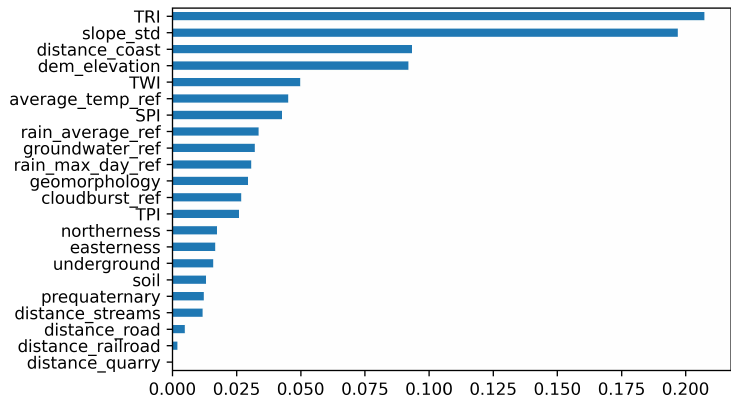
Figure 6. Feature importance from the RF model.